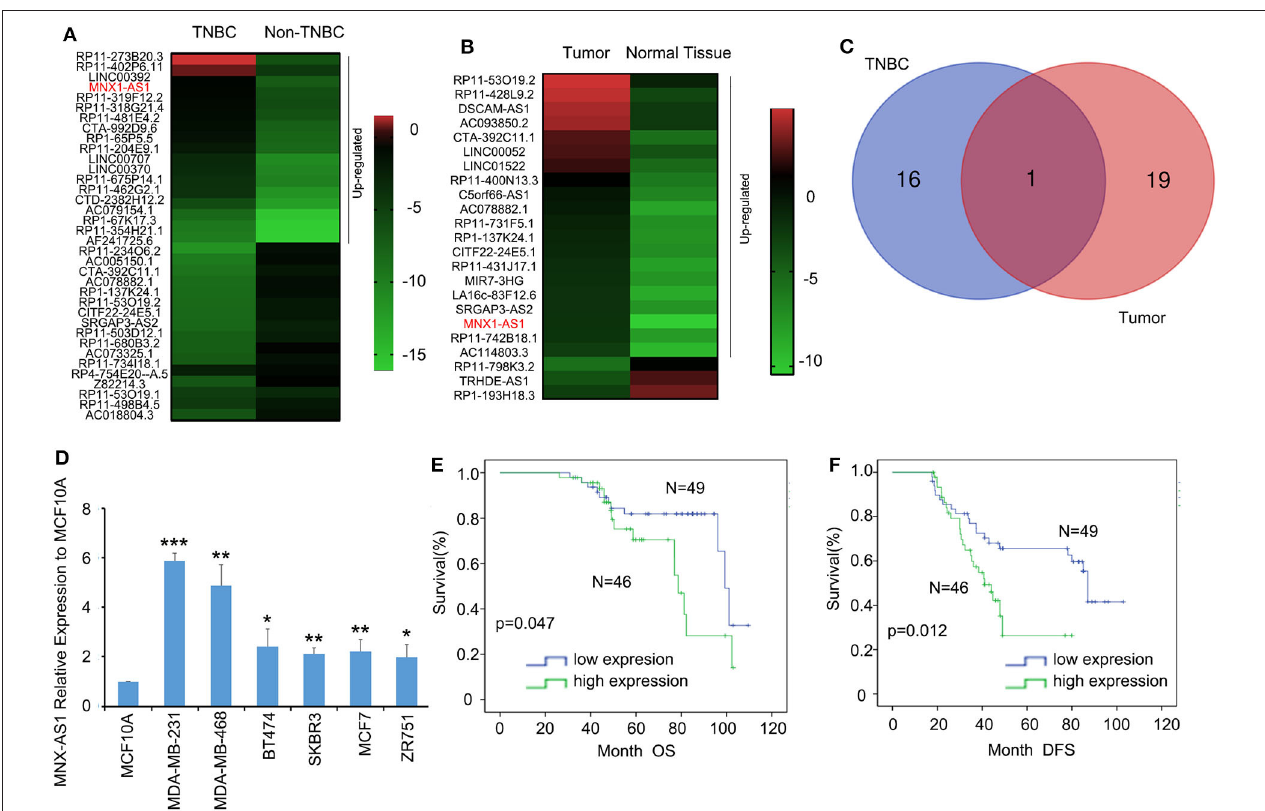
FIGURE 1 | Long non-coding RNA MNX-AS1 is upregulated in triple negative breast cancer (TNBC) and indicates poor survival outcome in breast cancer patients. (A) The heatmaps of lncRNAs that expressed 5-fold differentially between in triple negative breast cancer and non-triple negative breast cancer. The data were extracted from TCGA datasets Expression levels shown as log 2 transformed intensity relative to the mean value of all samples. (B) The heatmaps of lncRNAs that expressed 5-fold differentially between normal breast tissue and breast cancer tissues. The data were extracted from TCGA datasets. Expression levels shown as log 2 transformed intensity relative to the mean value of all samples. (C) The venn diagram showed the number of overlapping lncRNAs that were upregulated at least 5-folds in triple negative breast cancer and breast cancer samples. (D) LncRNA MNX1-AS1 is significantly upregulated in breast cancer cell lines comparing with normal breast epithelial cell line MCF10A and MNX1-AS1 was upregulated to greatest extend in TNBC cell lines MDA-MB-231 and MDA-MB-468. MNX1-AS1 expression was determined using qRT-PCR and normalized to MCF-10A expression. (E,F) Upregulated levels of MNX1-AS1 in triple negative breast tumors were detected by in situ hybridization (ISH) and associated with significantly poor overall survival (OS) and disease-free survival (DFS) in TNBC patients ( n = 95). * P < 0.05, ** P < 0.01 and *** P <